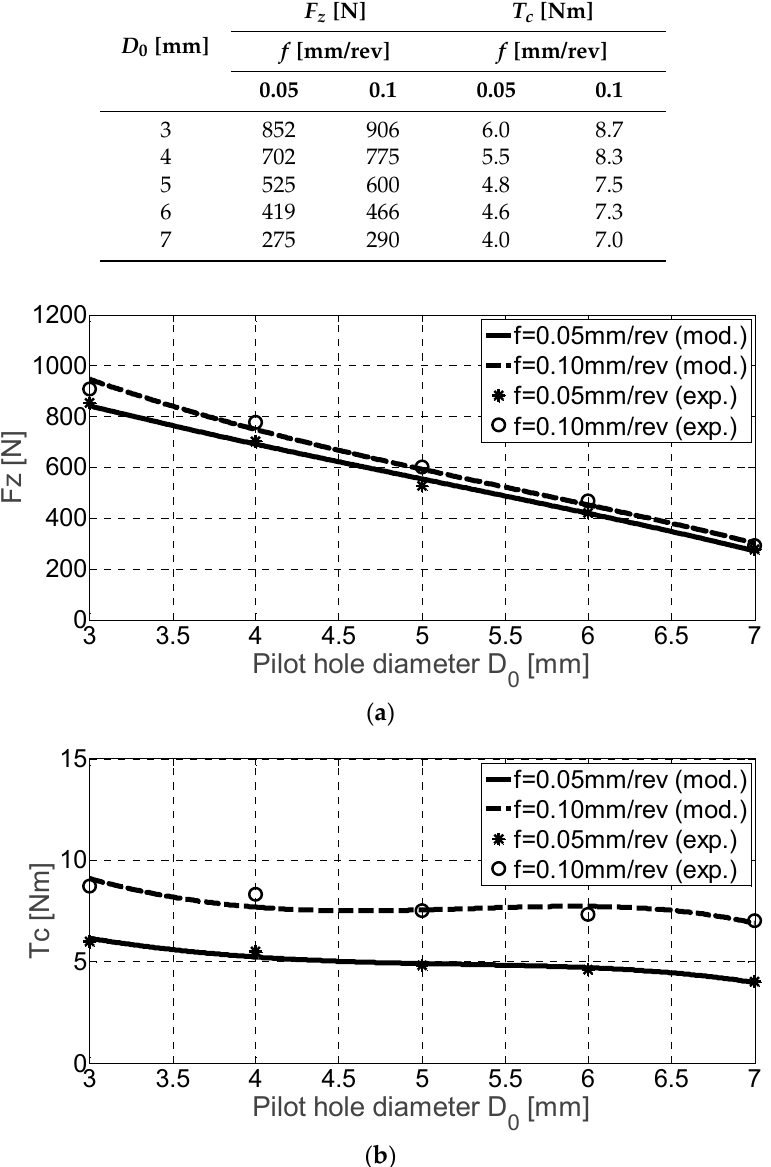
Figure 7. F z [N] ( a ) and T c [Nm] ( b ) for ingot MoCuSi alloy drilling experimental and mechanistic model values.